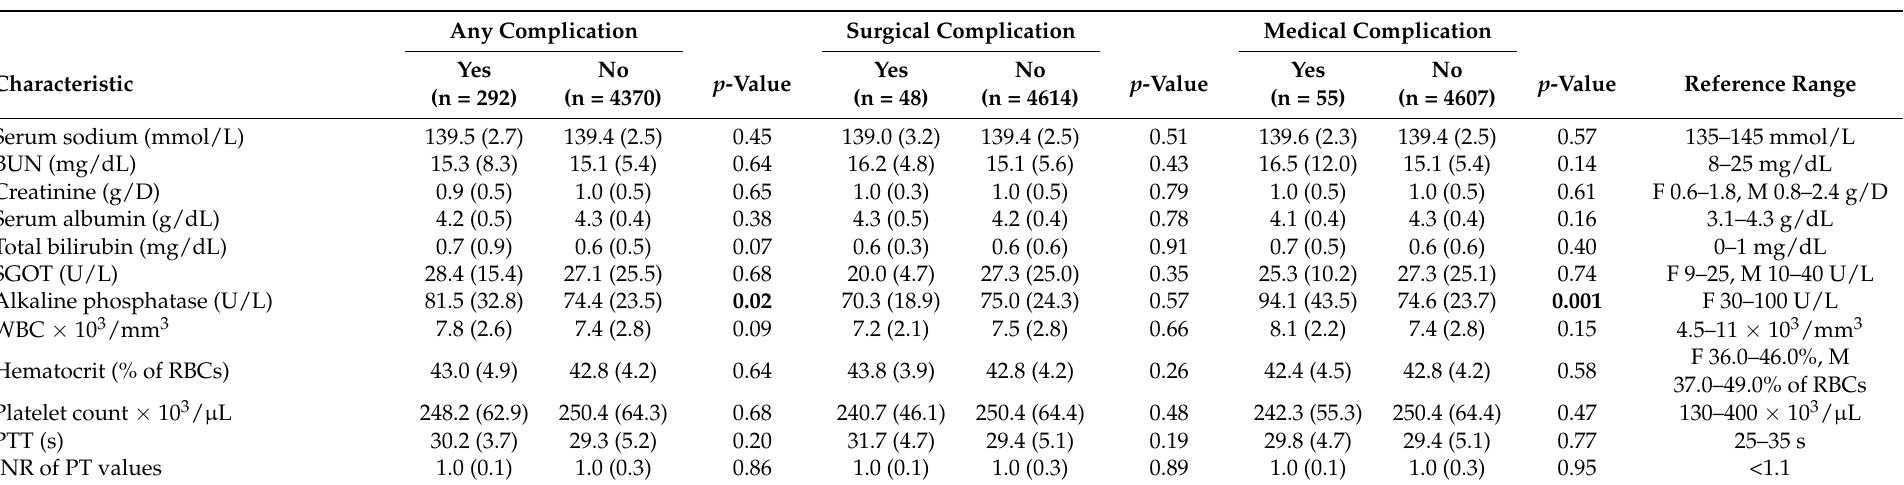
Table 9. Preoperative lab values for complications. Statistically significant p -values are highlighted in